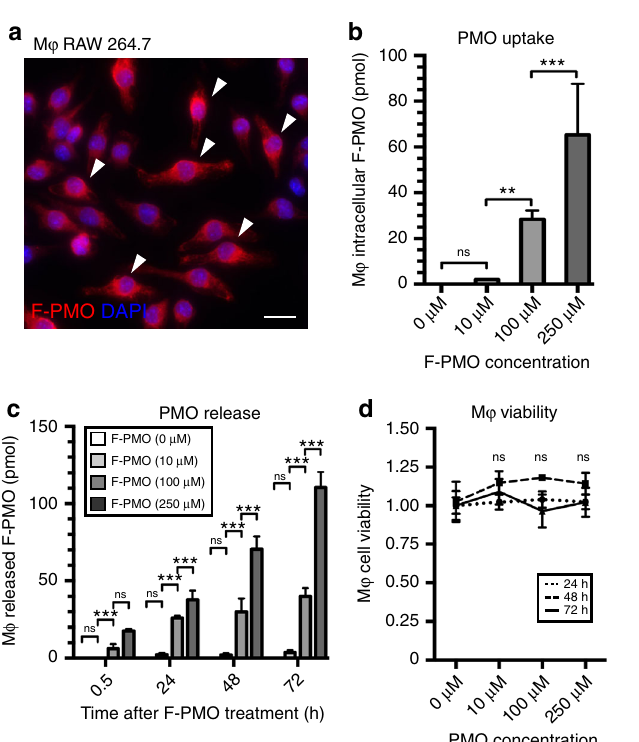
Fig. 9 Investigation of PMO uptake and release in cultured macrophages.